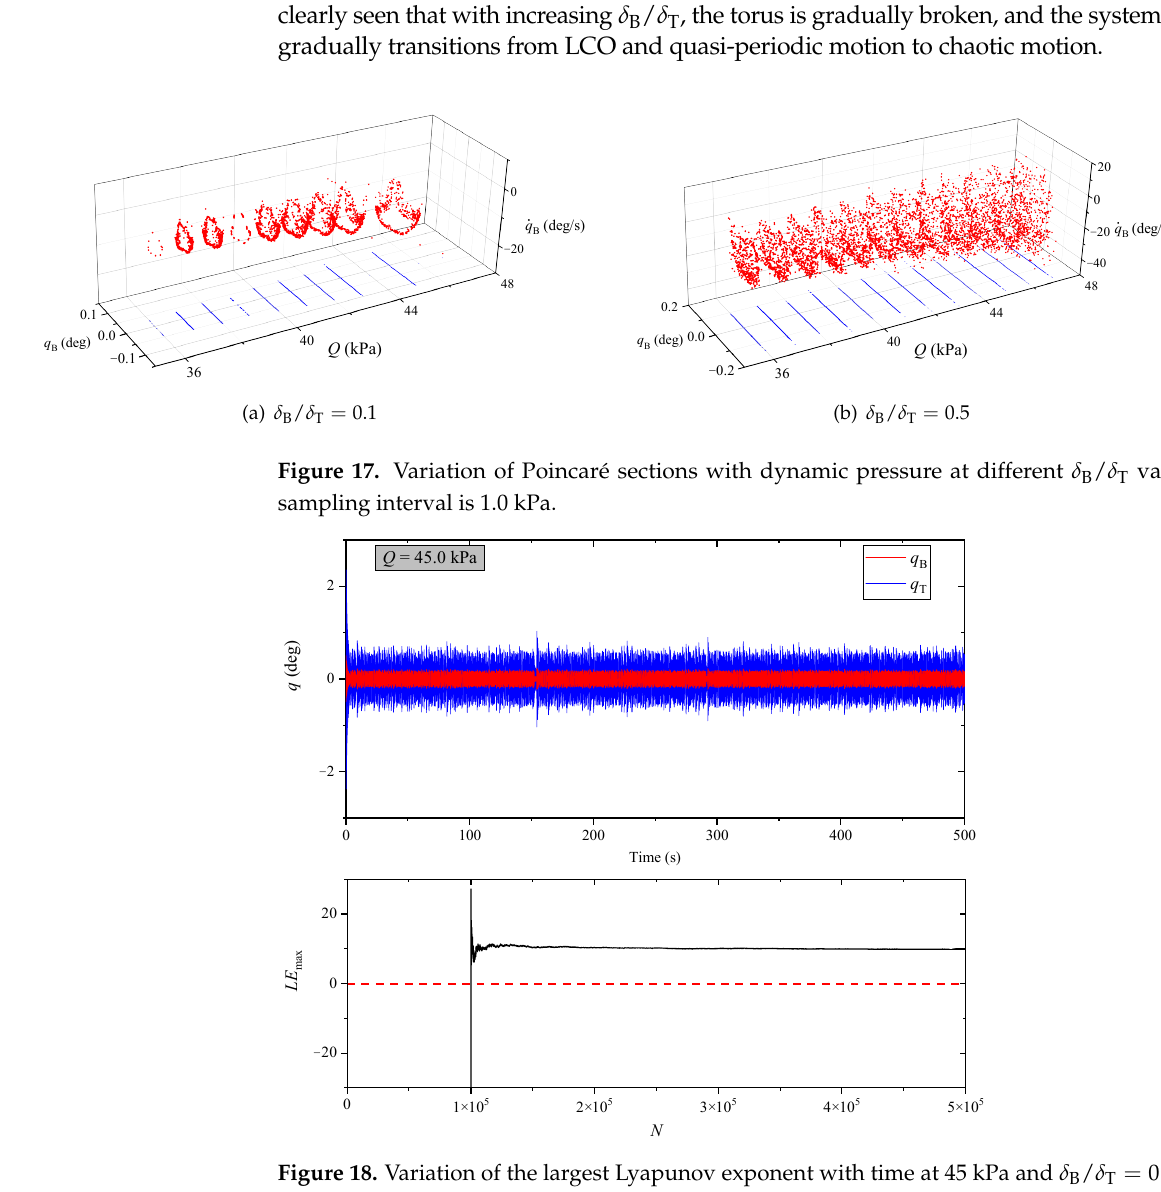
Figure 18. Variation of the largest Lyapunov exponent with time at 45 kPa and δ B / δ T =